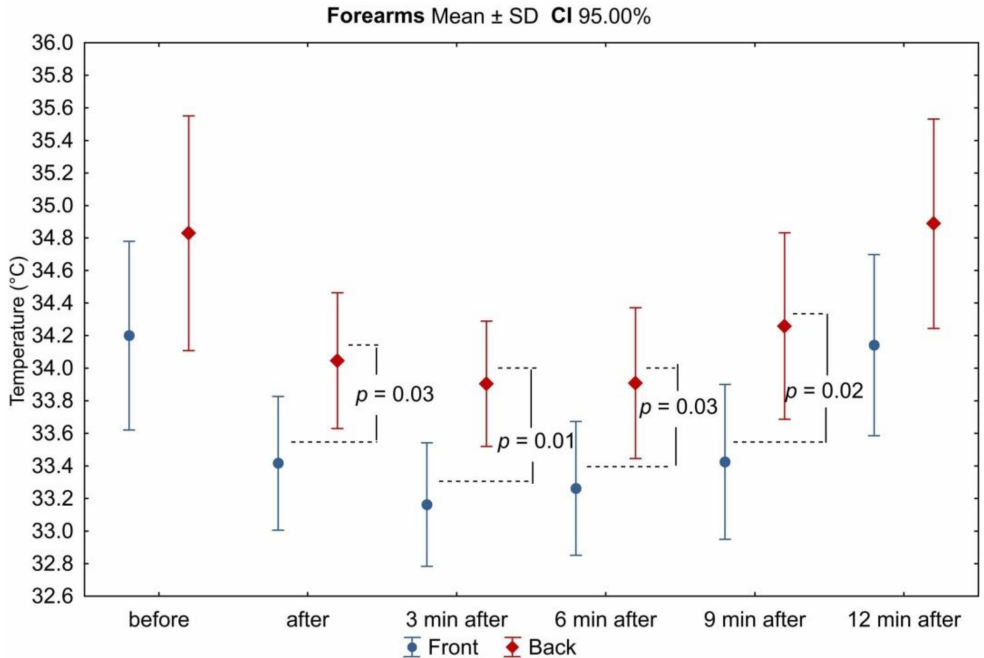
Figure 5. Differences in mean temperature values between the anterior and posterior surfaces of the forearms during successive measurement points before and after the exercise test. Legend: the test probability level of the student t -test between the temperature of the anterior and posterior surfaces. Data are expressed as mean with standard